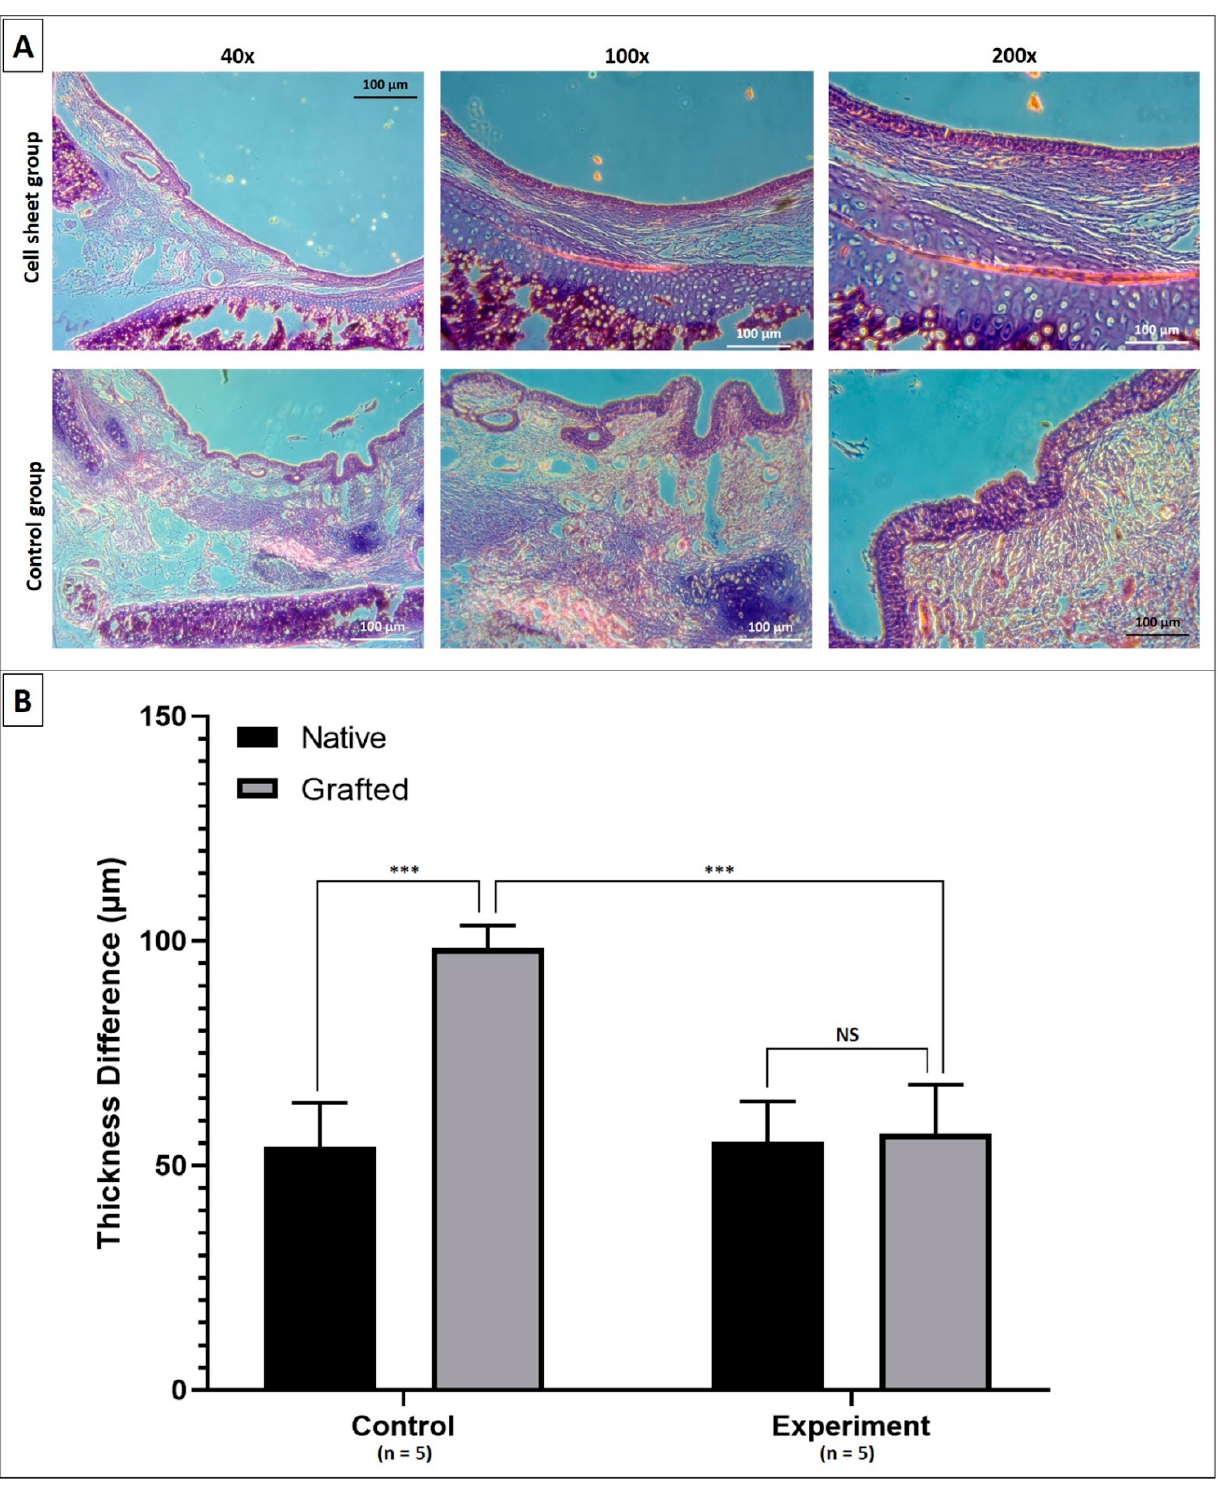
Figure 7. Histological examination of the transplanted grafts at two months post operation. ( A ): HE staining results of the transplanted grafts of the two groups under different magnitude views; ( B ): the graph showed that there was a significant difference in the thickness of the mucosal layer of the transplanted grafts between the two groups. (***) indicates statistical significance with p < 0.0001, NS means